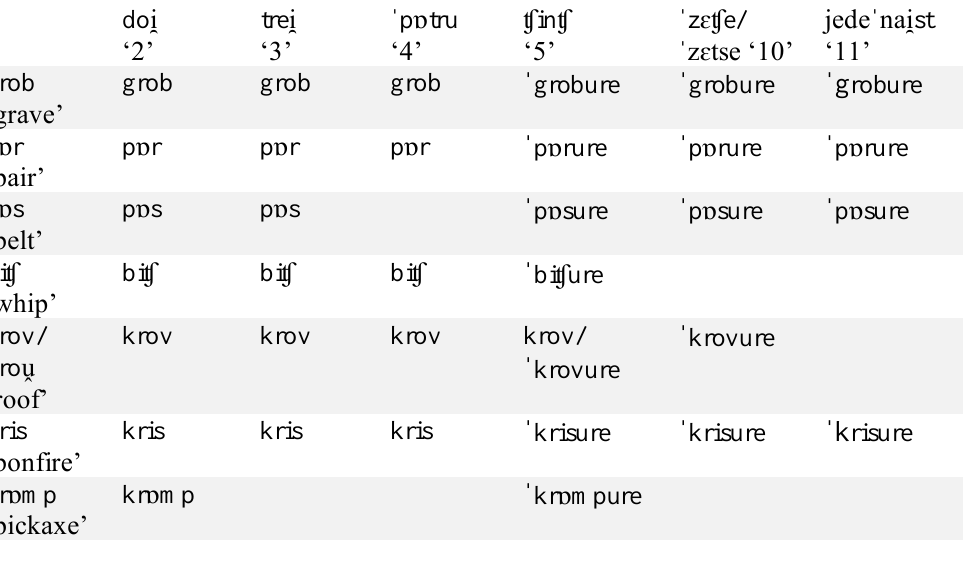
Table 13. Marking of the ‘five’ threshold by -ure in masculines that present consonantal alternations in phrases with ‘2’, ‘3’, ‘4’